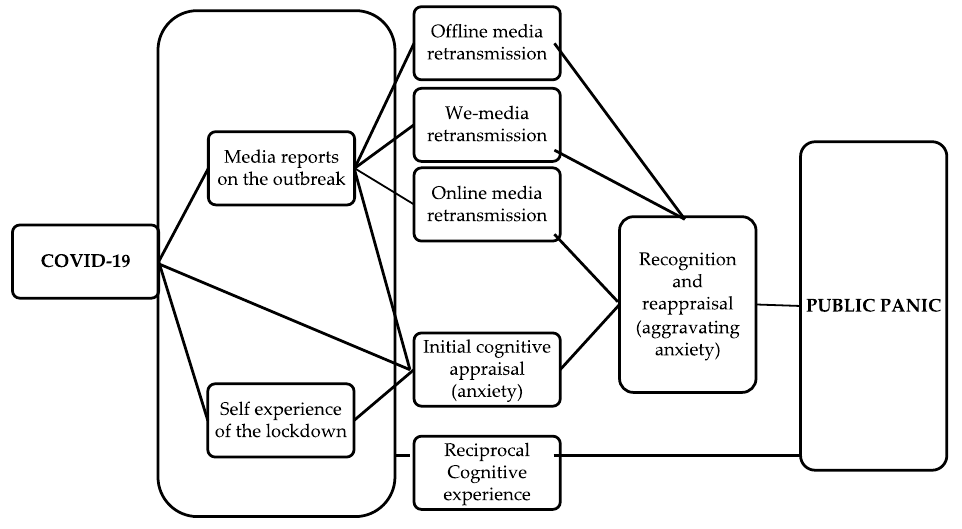
Figure 1. Conceptual framework.